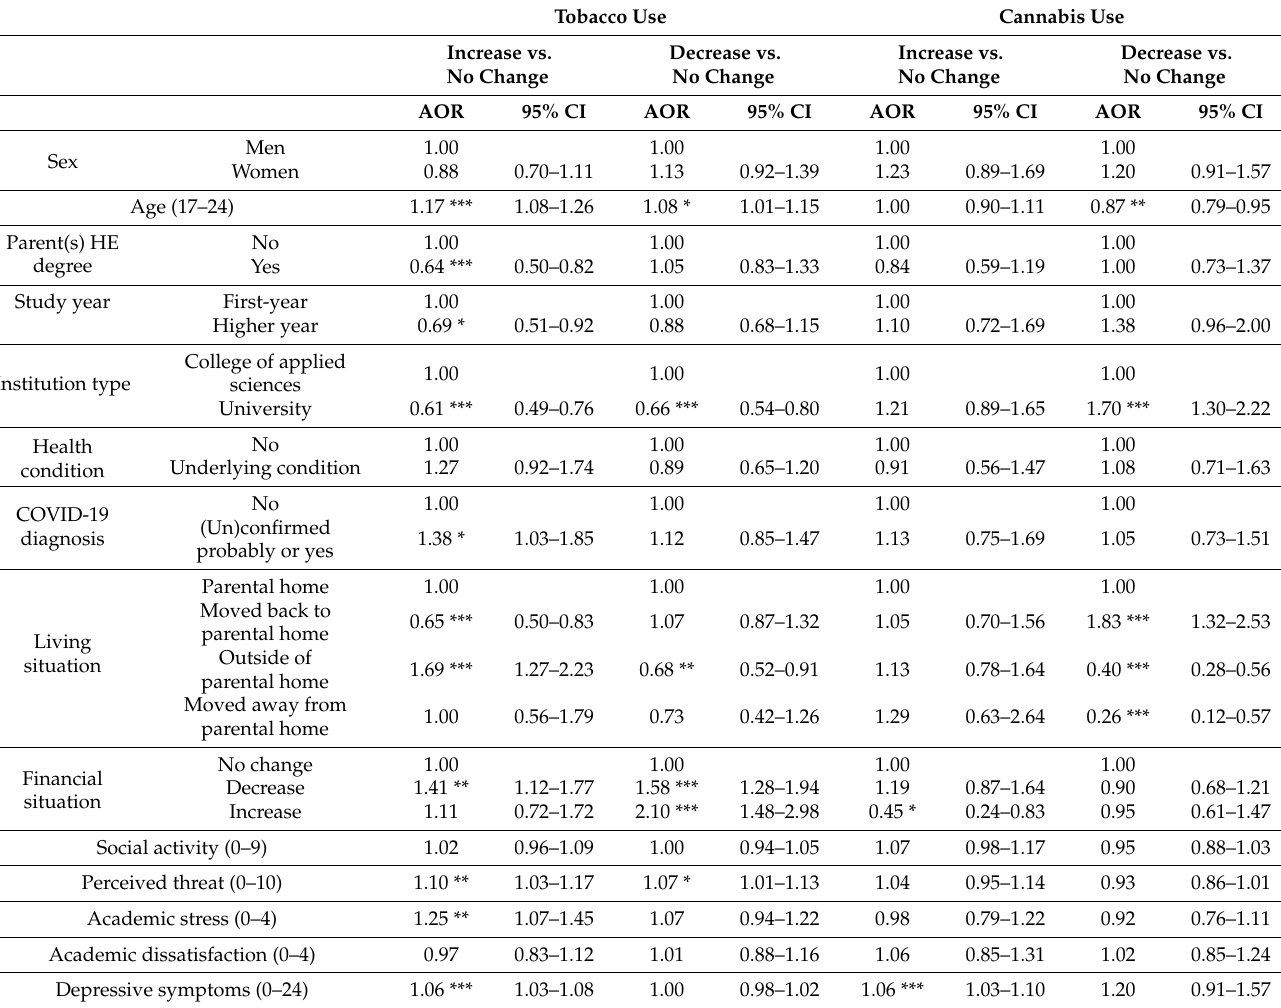
Table 4. Multinomial regression analyses for tobacco use and cannabis use ( n = 2653; n = 1804). Tobacco Use Cannabis Use Increase vs. Decrease vs. Increase vs. Decrease vs. No Change No Change No Change No Change AOR 95% CI